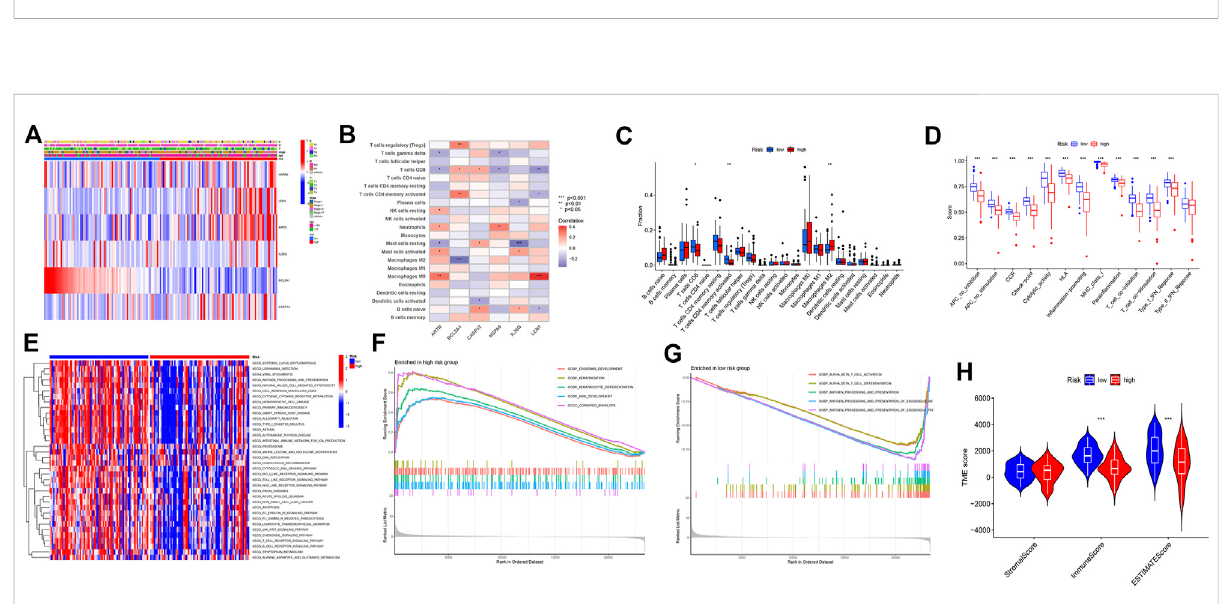
FIGURE 3 Immune landscape description of the high- and low-risk groups. (A) Six-gene expression in the high- and low-risk groups. (B) Six-gene expression and immune cell correlation analysis. (C) Immunocellular in fi ltration comparison of high- and low-risk groups. (D) Comparison of immune behavior in the high- and low-risk groups. (E) Pathway enrichment analysis by GSVA between the high-risk and low-risk groups. (F) Gene Ontology (GO) analysis of the high-risk group based on the gene set enrichment analysis (GSEA) results. (G) GO analysis of the low-risk group based on the GSEA results. (H) stromal, immune, and ESTIMATE scores in the high- and low-risk